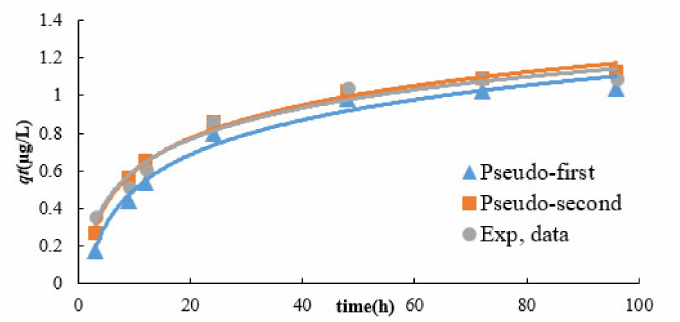
Figure 14. Pseudo-first-order and pseudo-second-order plot of Cr(VI) adsorption on the SDS-chitosan